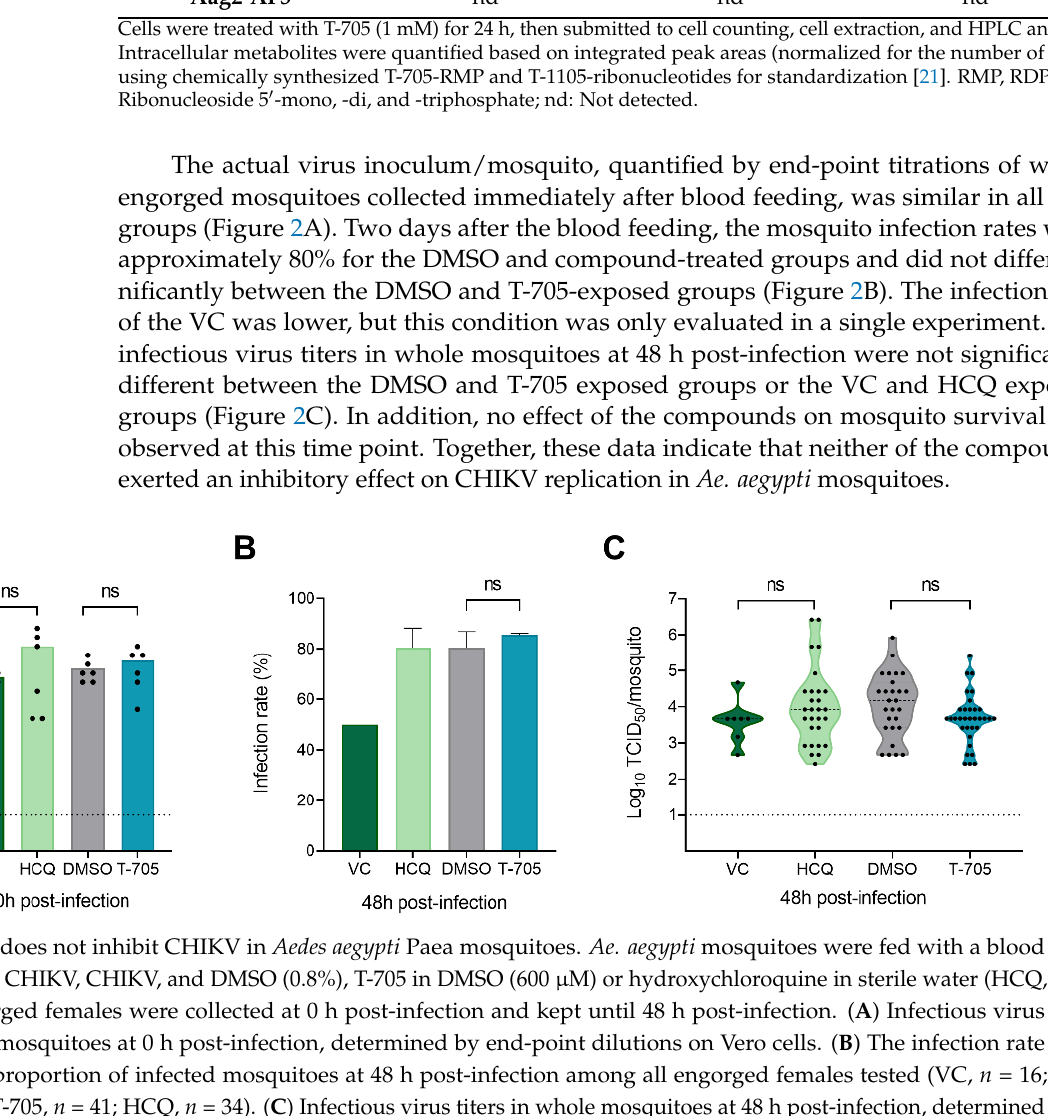
Table 1. Lack of T-705 metabolic activation in mosquito-derived cell lines. pmol of Metabolite/10 6 Cells Cell Line T-705-RMP T-705-RDP T-705-RTP Vero 222 ± 131 170 ± 108 309 ± 122 C6/36 nd nd nd Aag2-AF5 nd nd nd Cells were treated with T-705 (1 mM) for 24 h, then submitted to cell counting, cell extraction, and HPLC analysis. Intracellular metabolites were quantified based on integrated peak areas (normalized for the number of cells),